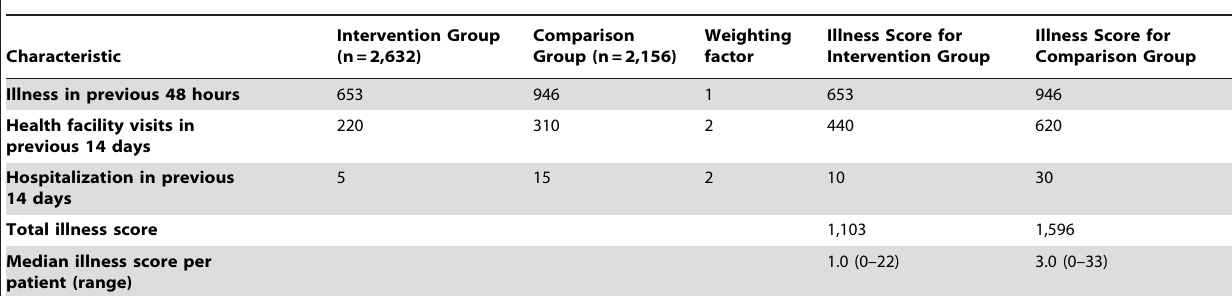
Table 5. Total number of illnesses, health facility visits, and hospitalizations reported over 16 weeks of basic care package evaluation, and illness scores derived from these events, by intervention and comparison group, Gonder and Debre Markos, Ethiopia, October 2009–January